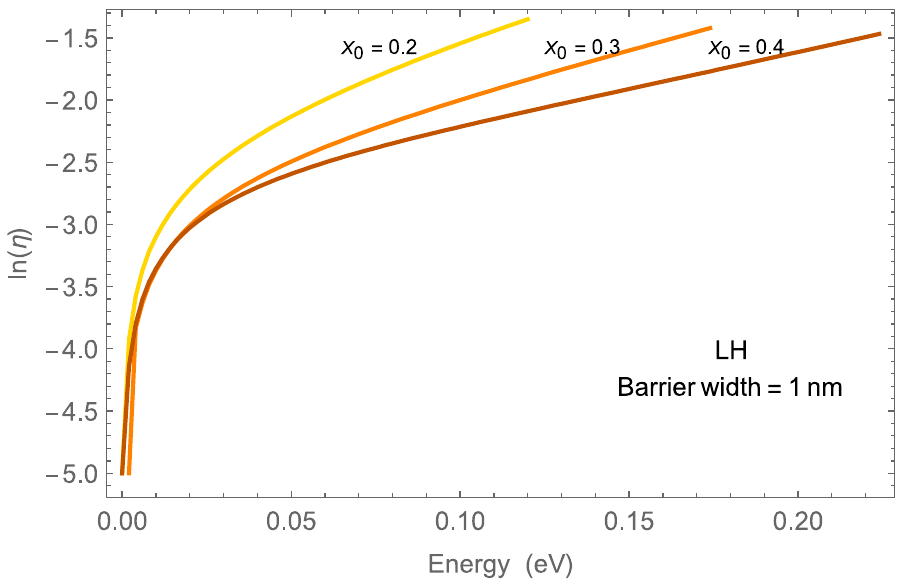
Figure 10. Logarithm of the transmission coefficient for LH as a function of energy for the double- barrier In x Ga 1 − x N/GaN parabolic quantum well structure with various x 0 at an applied bias of 0.8 V, and barrier width 1 nm.